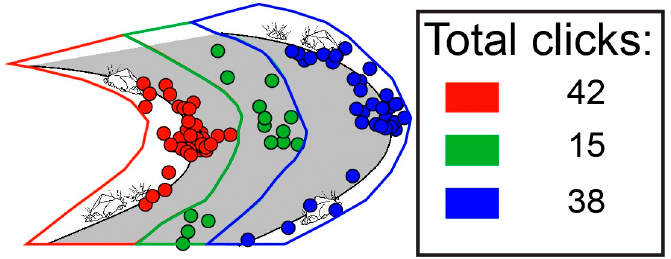
Figure 6. Polygons and student clicks in response to the prompt, “Click in the river where you expect to find erosion”. The correct region, labeled in blue ( n = 38), is the outside of the river bend. The region labeled in red ( n = 42) and green ( n = 15) will have relatively lower velocity and erosion.